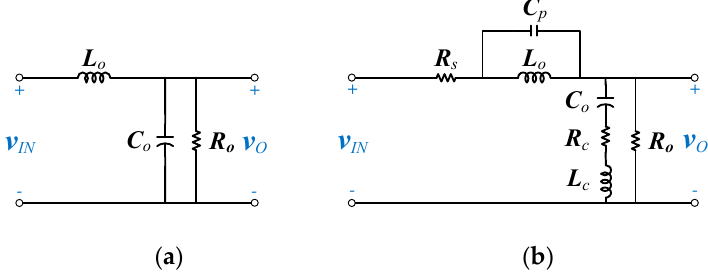
Figure 2. LC low-pass filter ( a ) ideal model; ( b ) non-ideal model.